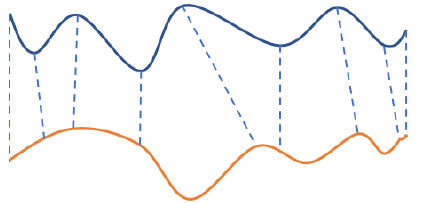
Figure 3. Illustration of 2D point cloud registration.